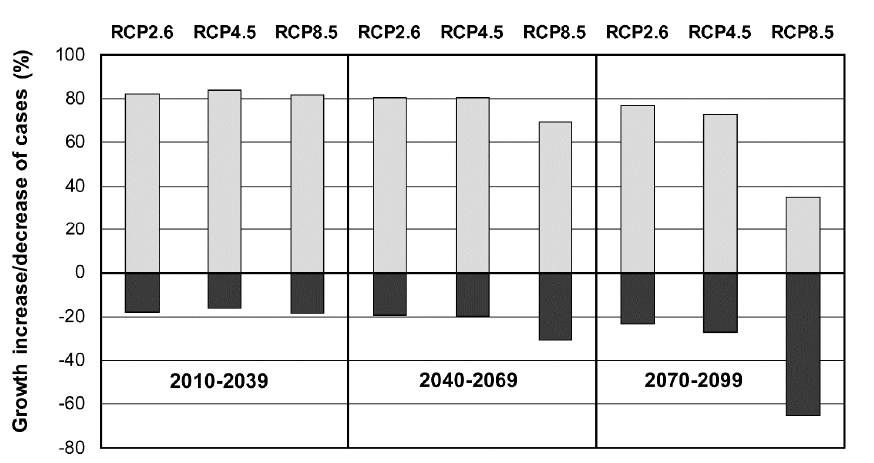
Figure 5. Percentage distribution of declining and increasing growth changes of the total number of cases for minor (RCP2.6), moderate (RCP4.5), and severe (RCP8.5) climate change scenarios over all upland forest inventory plots for different 30-year calculation periods (2010–2039, 2040–2069, and 2070–2099) across the whole country. If drained peatland sites were included in calculations, positive responses of growth would have been slightly higher and negative responses lower (see Table 5).